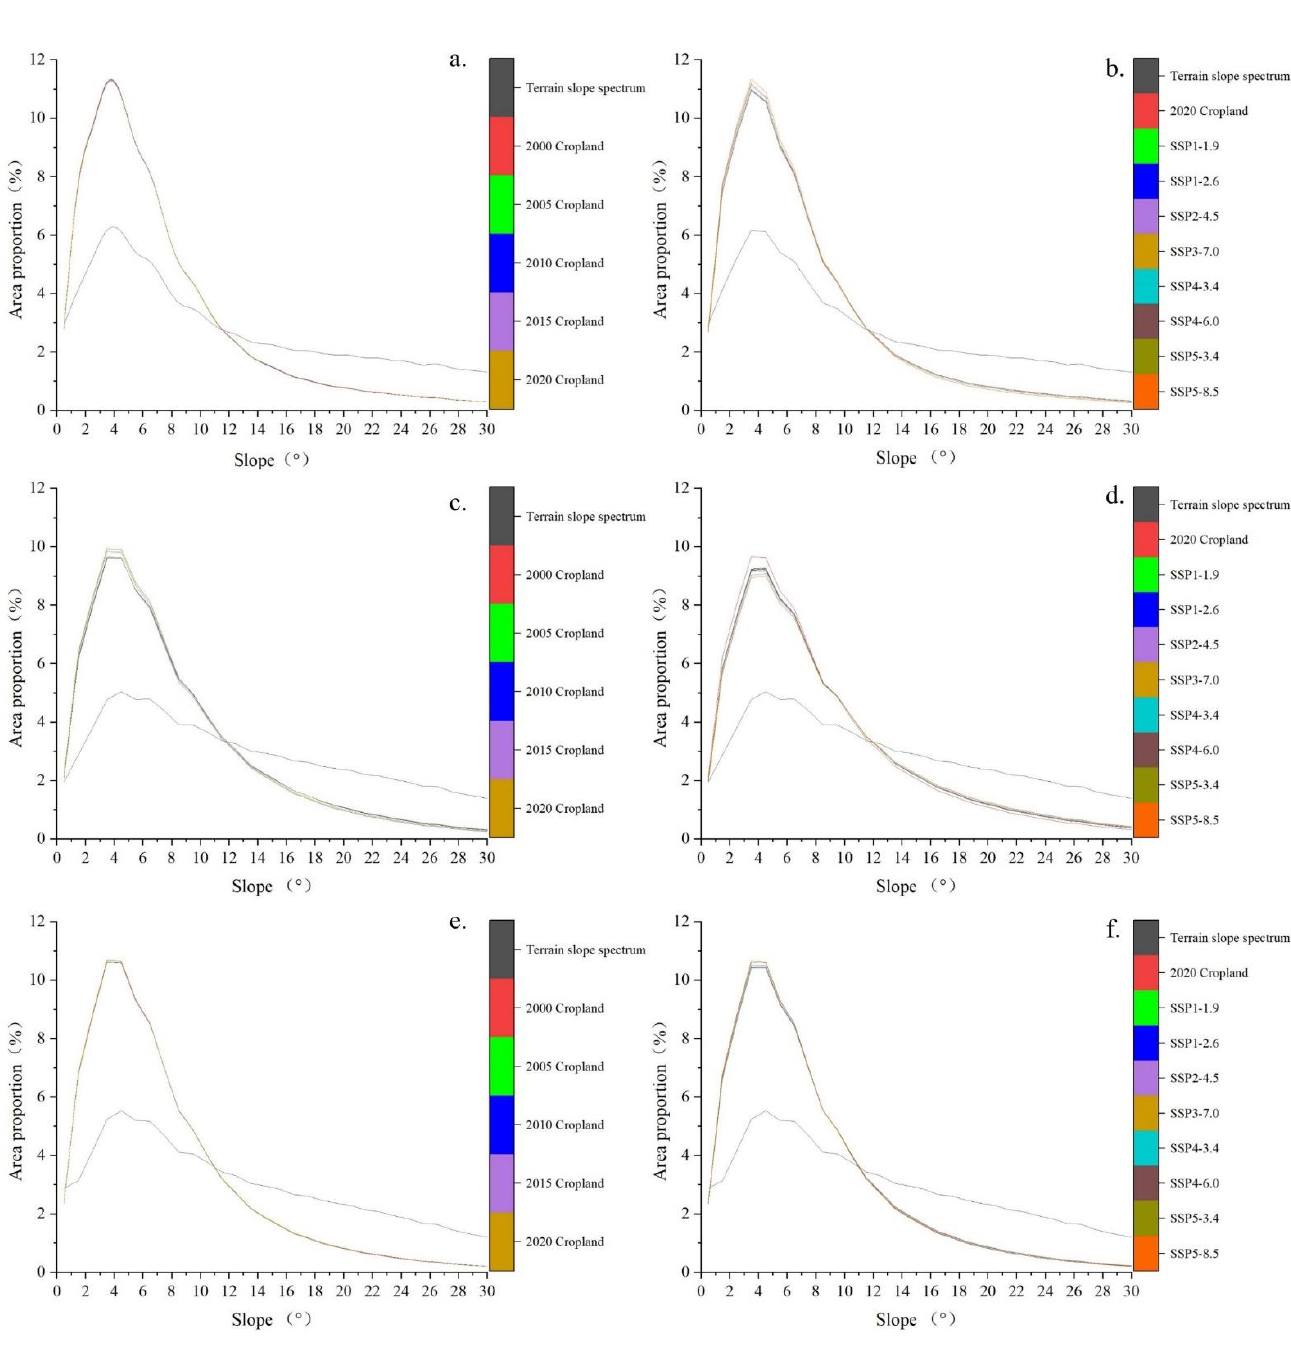
Figure 10. Cropland slope spectra for Hubei, Hunan, and Jiangxi during 2000 – 2020 and predictions of 2035 under different scenarios. ( a ) Cropland slope spectra for Hubei during 2000 – 2020; ( b ) Cropland slope spectrum simulations for Hubei in 2035; ( c ) Cropland slope spectra for Hunan during 2000 – 2020; ( d ) Cropland slope spectra simulations for Hunan in 2035; ( e ) Cropland slope spectra for Jiangxi during 2000 – 2020; ( f ) Cropland slope spectra simulations for Jiangxi in 2035.